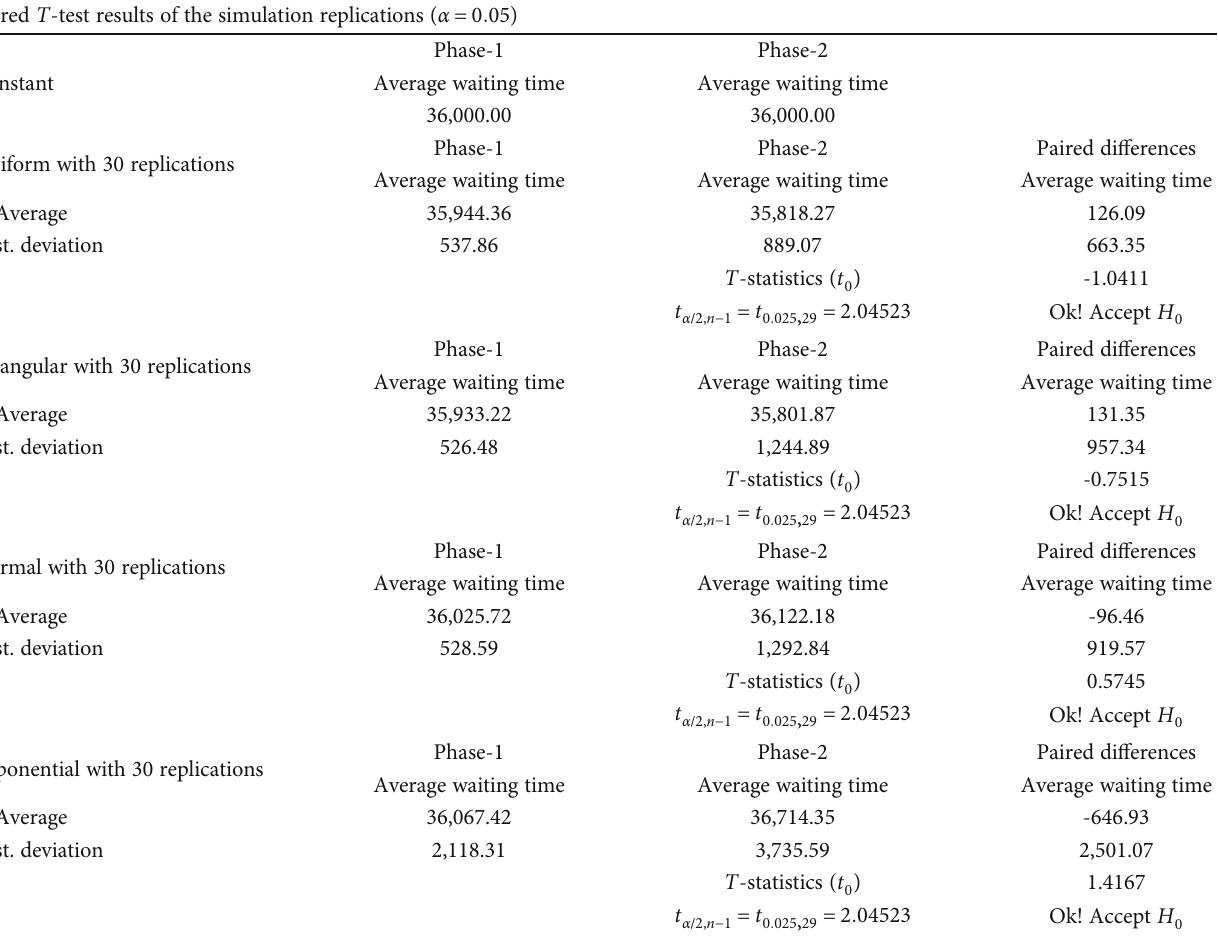
Table 4: Results of hypothesis testing for constructed paired T -tests to compare phase-1 and phase-2 average waiting times for four interarrival distributions: uniform, triangular, normal, and exponential. Mean interarrival rates for all distributions in phase-2 are 75 tertias. Paired T -test results of the simulation replications ( α = 0 : 05